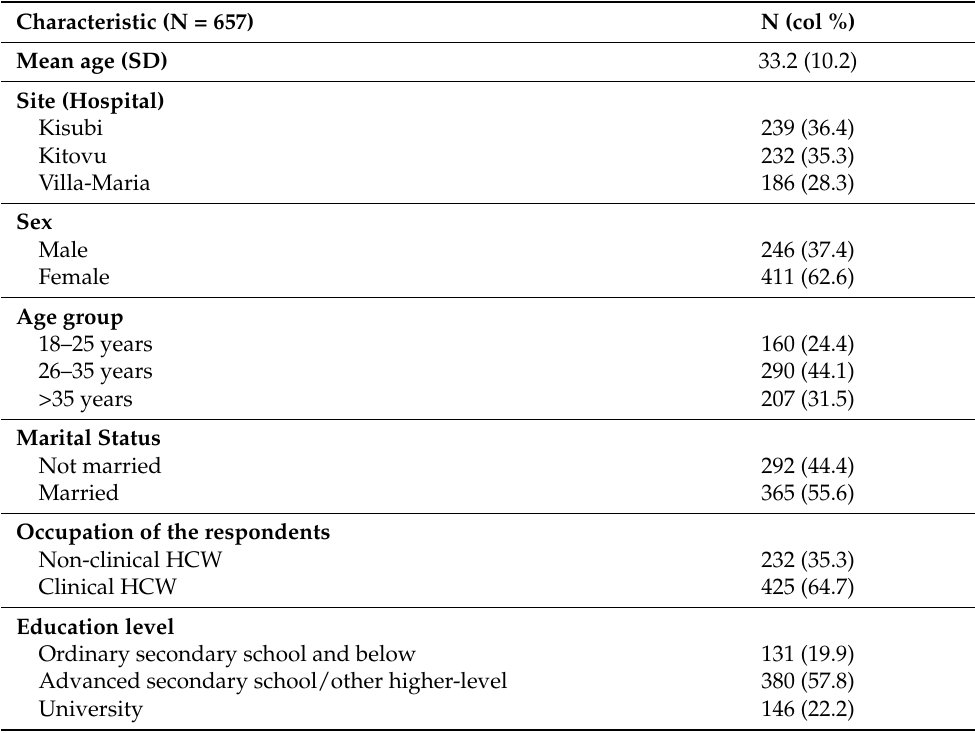
Table 1. Participant socio-demographic